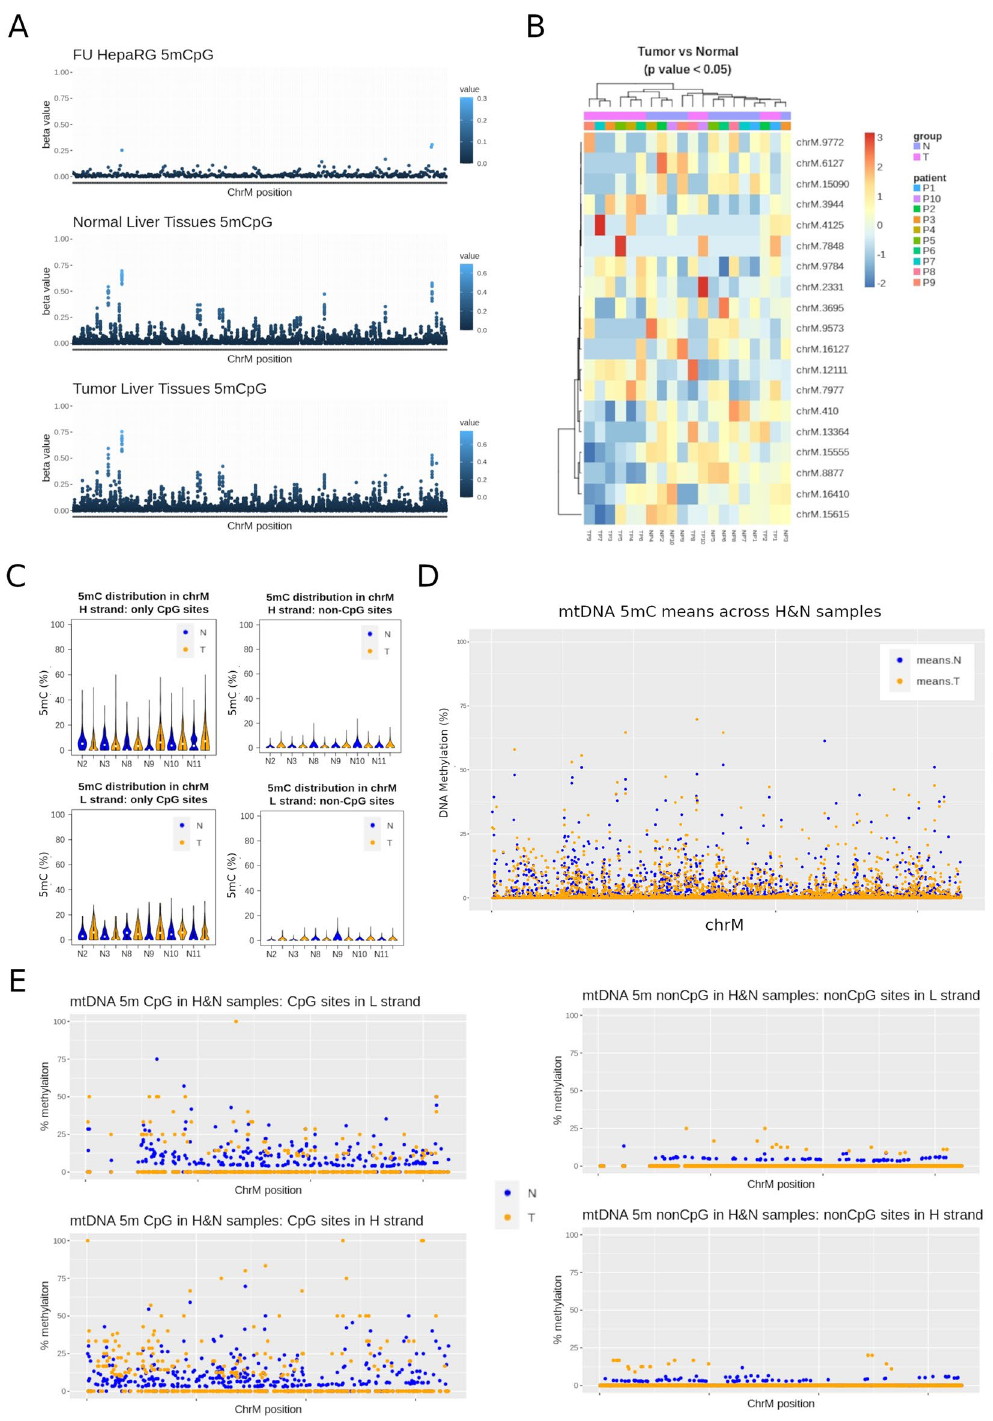
Figure 7. Long read DNA methylation in cancer. ( A , B ) DNA was extracted from 10 hepatocellular carcinoma (HCC) patients and matched non-tumor adjacent tissues. After sequencing with a PromethION device, all-context cytosine modifications were called with Megalodon. ( A ) 5mCpG values are shown after nanopore sequencing of a fully unmethylated (FU) liver cell ine (HepaRG, top panel), 10 non-tumor liver tissues (middle panel), and 10 matched tumor tissues (bottom panel). ( B ) 5mCpG heatmap of top most significant (lowest p value in the paired Tumor vs. surrounding comparison) CpG sites. Annotations include Tumor (T) vs Normal (N) status, and patient ID (P1 to P10). ( C–E ) DNA was extracted from 6 head and neck cancer (HNC) patients and matched non-tumor adjacent tissues. After sequencing with a MinON device, all- context cytosine modifications were called with Megalodon. ( C ) 5mC distribution in mtDNA represented as percentage of methylation (5mC %). Values are presented by strand (H strand in top panels, L-strand in bottom panels) and context (CpG sites on the left, CpH sites on the right). ( D ) Mean mtDNA 5mC values across all HNC tumors (means.T) and their matched adjacent tissues (means.N). All cytosines are represented. ( E ) A more stringent analysis was performed after removing low coverage sites and all reads below the length of the longest NUMT sequence (~ 8 kb). Means of HNC tumors (T) and adjacent tissues (N) are presented by strand and cytosine context